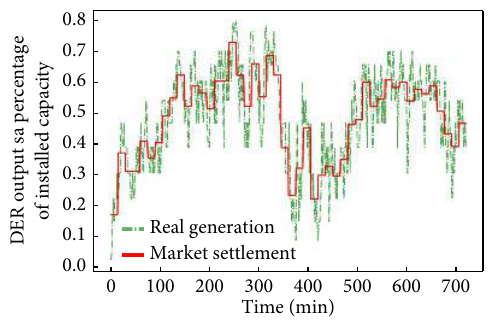
Fig. 2 Fluctuation of DER output under different timescales.